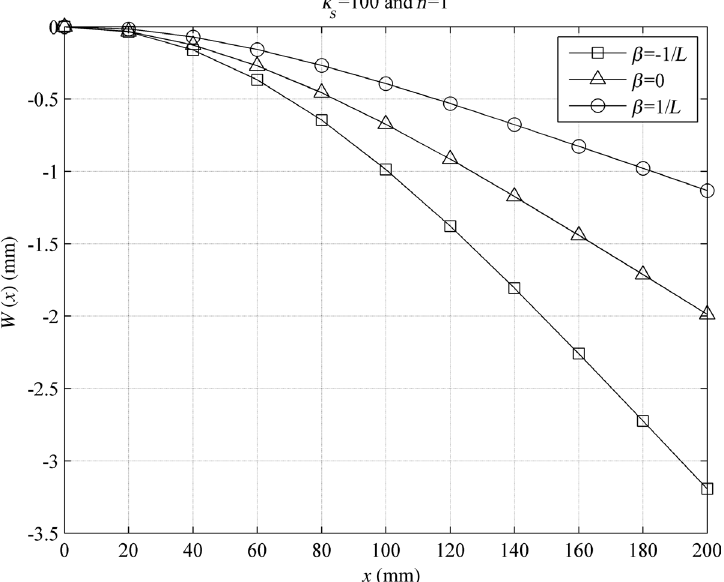
Figure 9 The first mode shape of the cantilever FG beam on elastic foundation for various geometric indexes ( k